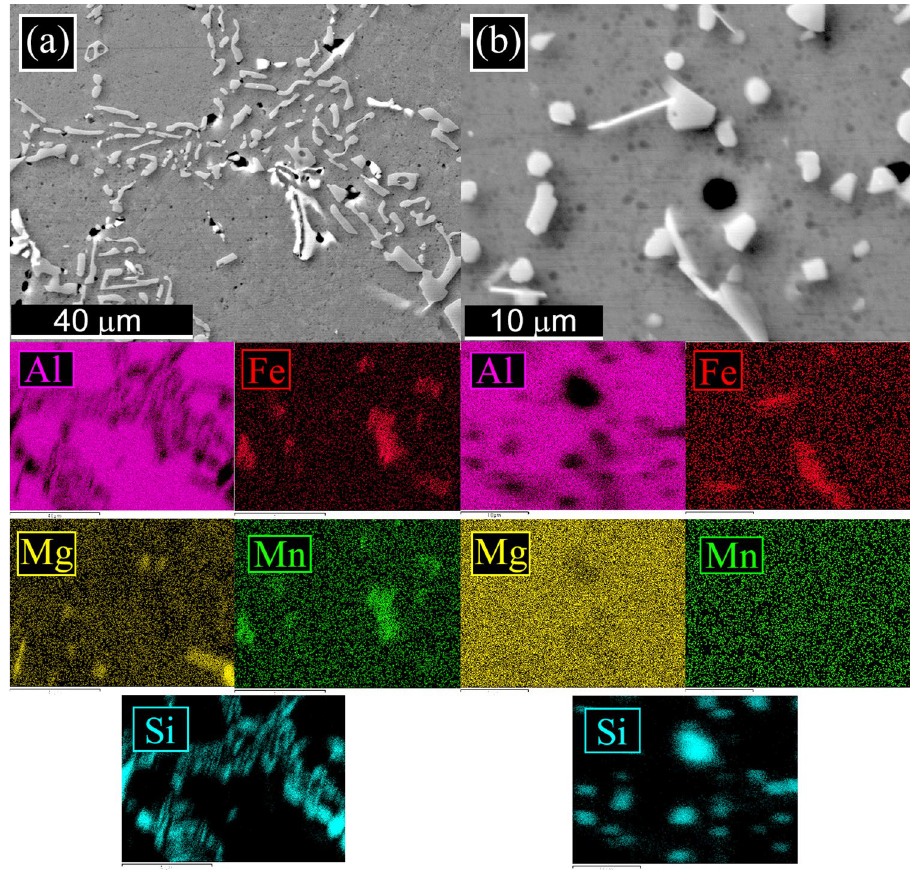
Figure 4. Scanning electron microscope (SEM) images with EDS elemental maps of the cast sample ( a ) and of the solution treated sample ( b ) to highlight the distribution of the elements on the surface.